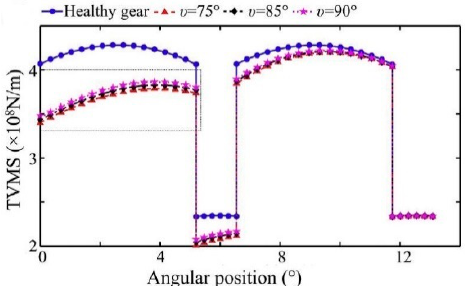
Figure 3. Meshing stiffness by the finite element method (FEM).